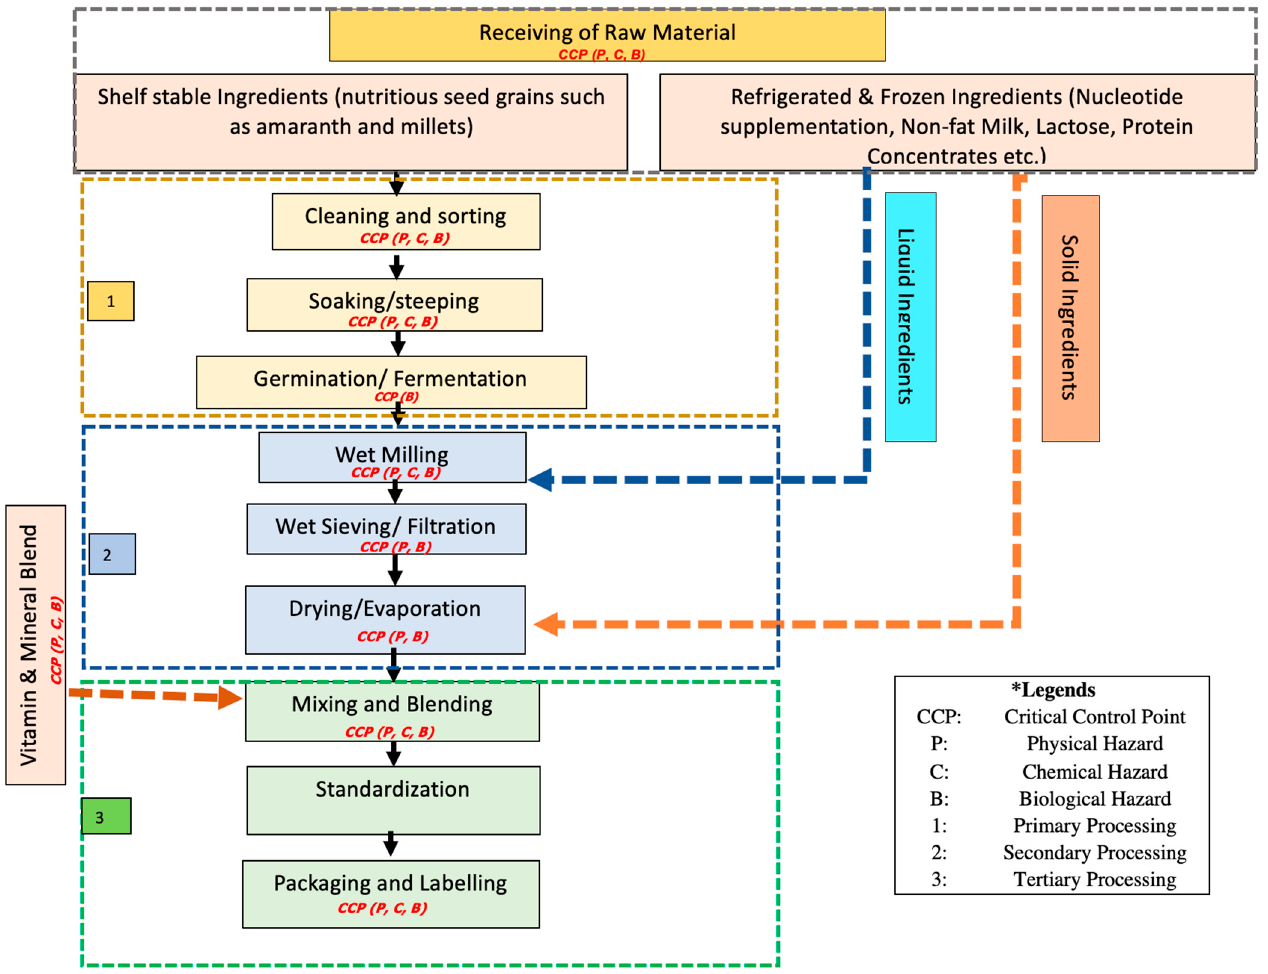
Figure 2. Process flow diagram of complementary food illustrating all the processing steps involved in production, wherein different controls can be set for monitoring the critical limits.